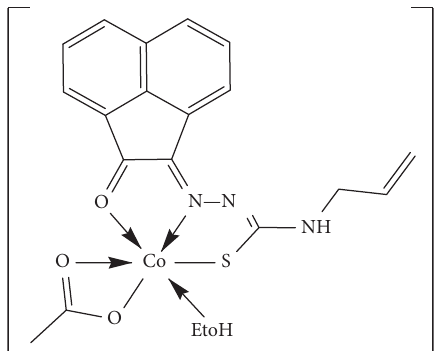
Figure 2: Suggested structure of Co(II) complex.